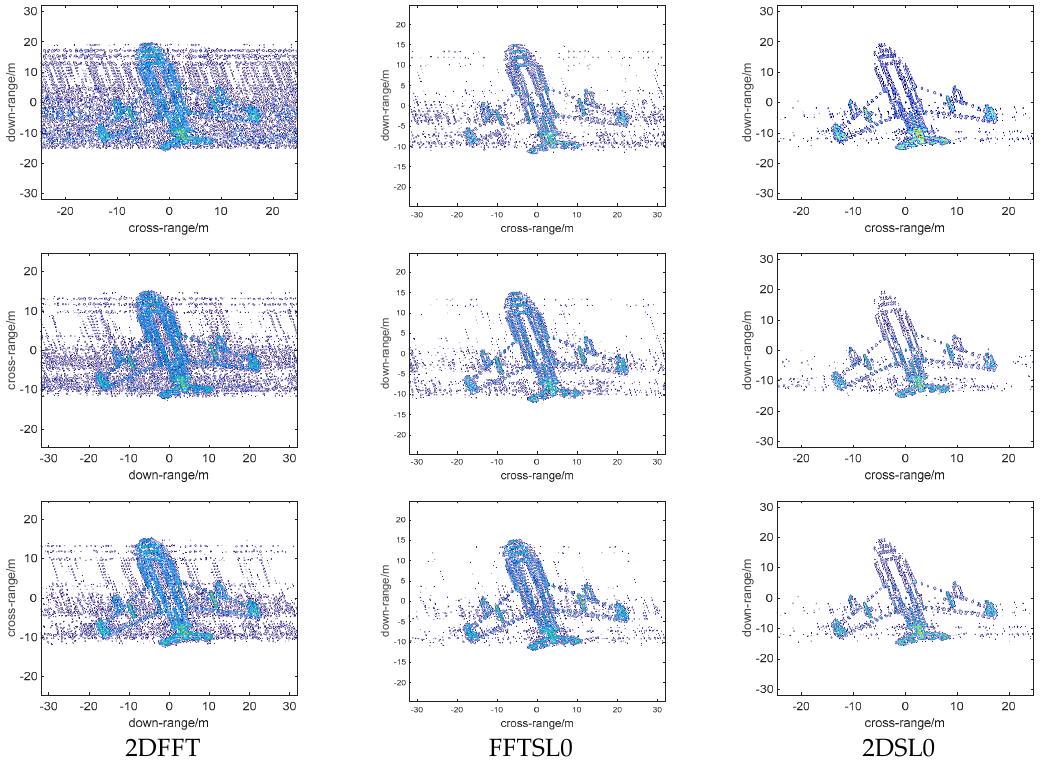
Figure 9. Bi-ISAR imaging results with different reconstruction methods versus measurements. Column 1 represents 2DFFT images, Column 2 represents FFTSL0 images, and Column 3 represents 2DSL0 images. Row 1 represents 50% of echo data, Row 2 represents 65% of echo data, and Row 3 represents 78% of echo data.